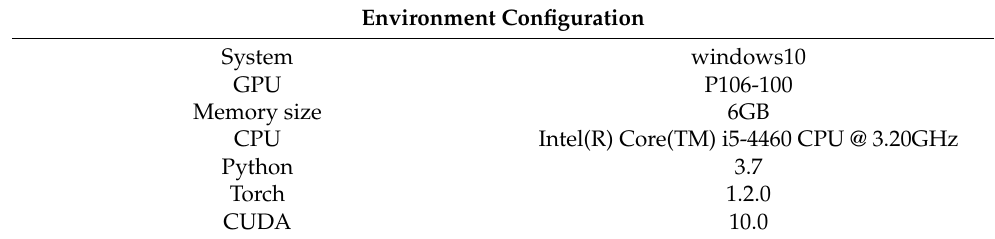
Table 1. Experimental training environment.